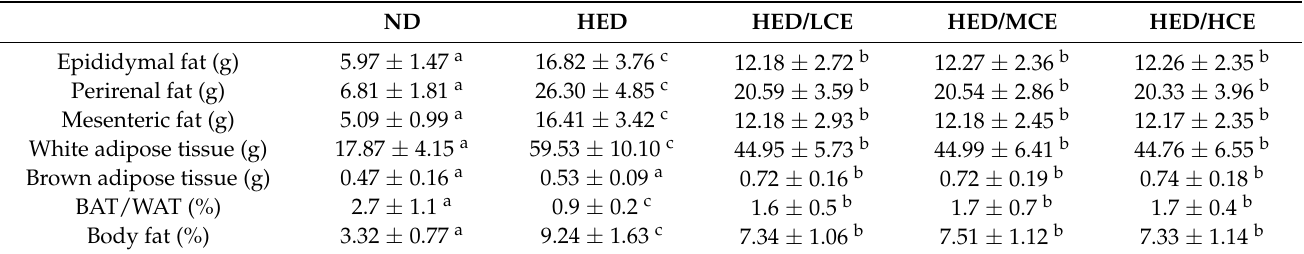
Table 1. Effects of phlorotannin-rich extracts from A. nodosum and F. vesiculosus on the mass of the epididymal, perirenal, and mesenteric fat pads and total body fat of rats with high-energy diet–induced hyperlipidemia.